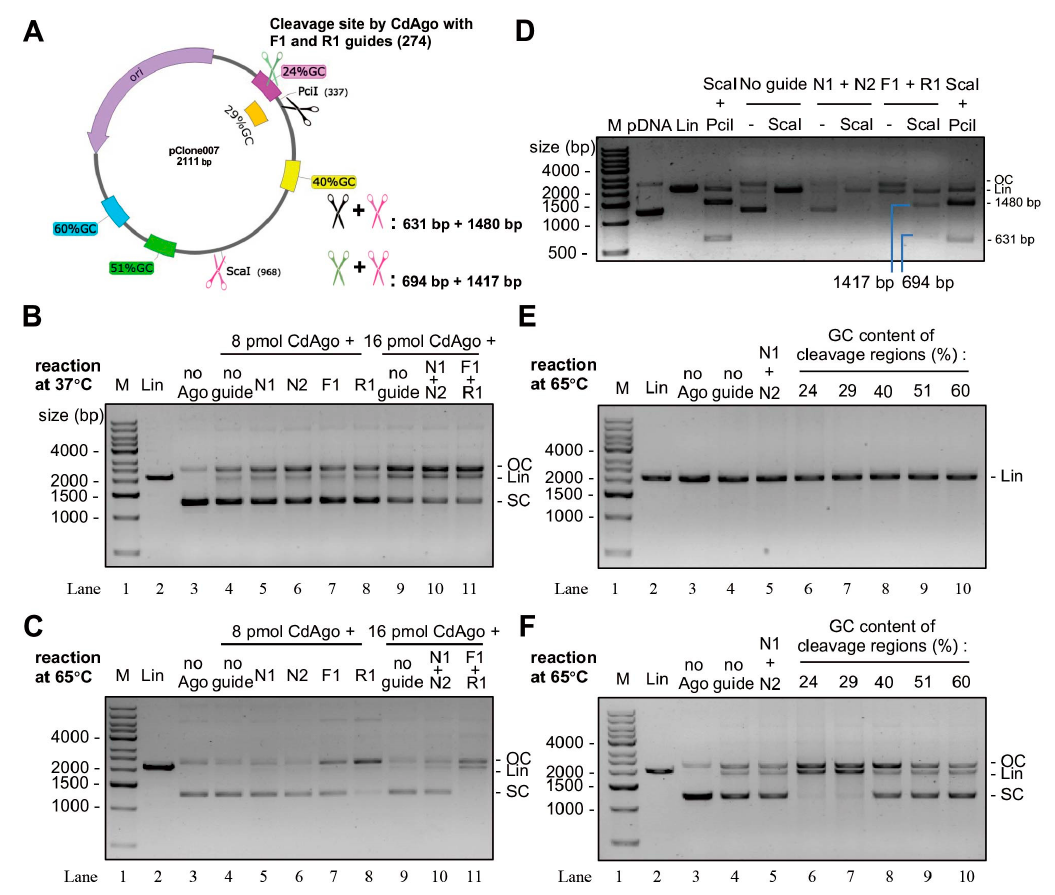
Figure 5. Guided cleavage of supercoiled plasmid DNA by CdAgo. ( A ) The target regions of the plasmid in the cleavage reactions in ( B – D ). ( B ) The CdAgo cleavage of supercoiled plasmid at 37 ◦ C. ( C ) The CdAgo cleavage of supercoiled plasmid at 65 ◦ C. ( D ) The double digestions by ScaI and CdAgo in the presence of F1 and R1. pDNA, supercoiled plasmid DNA. ( E ) CdAgo reactions with linearized plasmid DNA and gDNAs directed against different target sequences (see panel A) with varying GC content. ( F ) As panel E, but using supercoiled plasmid DNA. M, DNA markers; SC, supercoiled plasmid DNA; OC, open circular plasmid; Lin, linearized plasmid